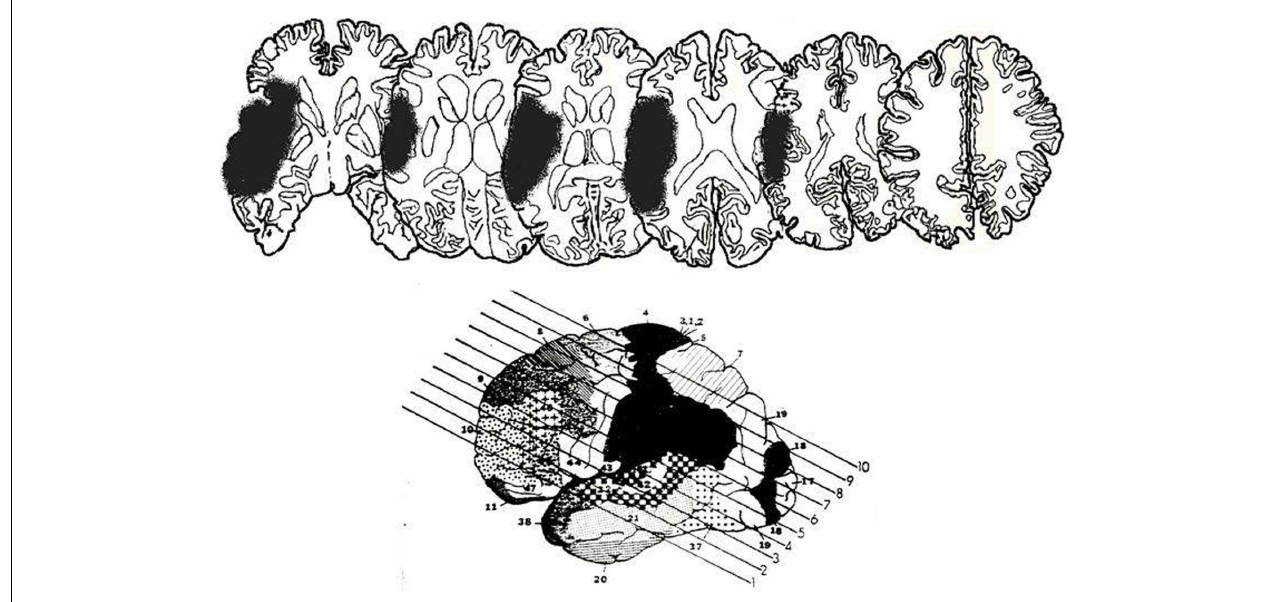
FIGURE 1 | Lesion reconstructions for LR, from MRI scan .The lesion has been drawn onto standard slices from Gado et al. (1979).The bottom figure shows the 10 slices used. Only slices three to eight are depicted here.The left of each slice represents the right